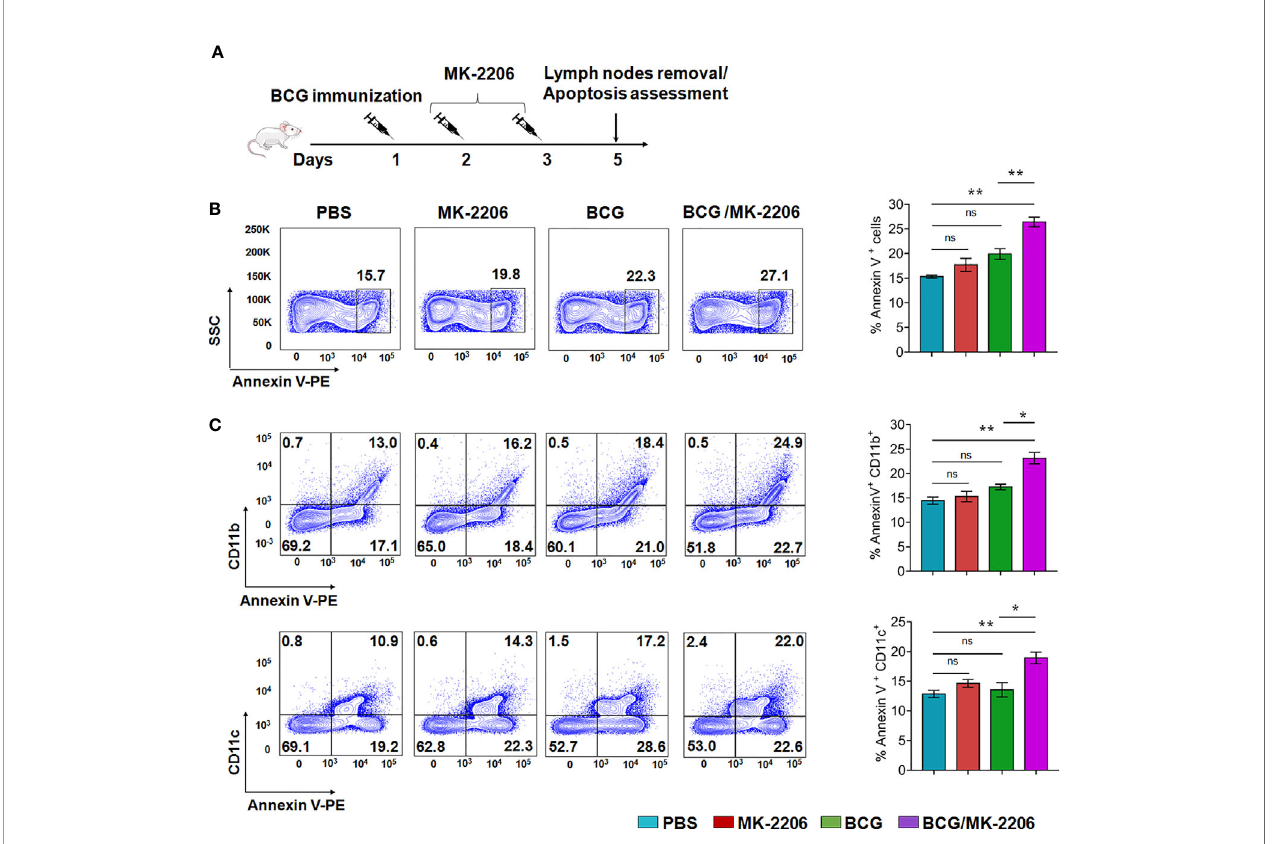
FIGURE 2 | MK-2206 enhances apoptosis in lymph nodes of BCG-vaccinated mice. (A) Schematic design of homologous route prime-boost vaccination strategy in mice. Animals were mock treated or primed subcutaneously with 1 × 10 6 BCG at day 1. Two and three days later, two groups of mock and BCG-vaccinated mice were administered MK-2206 (25 mg/kg) via subcutaneous route. Five days after administration, mice (n = 4 – 5/group) from a single experiment were sacri fi ced and apoptosis was measured by fl ow cytometry in draining lymph nodes using Annexin V staining. (B) Representative dot plots of apoptotic cells (Annexin V+) in lymph nodes from different groups are shown. (C) Frequencies of Annexin V positive cells among CD11b + and CD11c + subsets were measured in DLNs. The data shown in these panels is mean ± SEM of the results obtained from a single experiment (n = 4 – 5 mice/group). Statistical differences were obtained between the indicated groups *p < 0.05; **p < 0.01; ns, non-signi fi